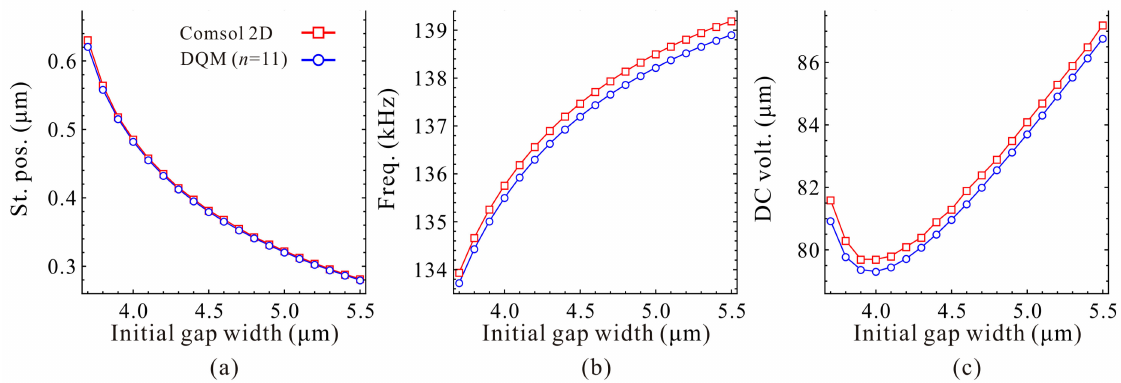
Figure 17. Quantitative property of the static position (St. pos.) ( a ), fundamental frequency (Freq.) ( b ) and DC voltage (DC volt.) ( c ) corresponding to point C 1 on frequency curve versus initial gap